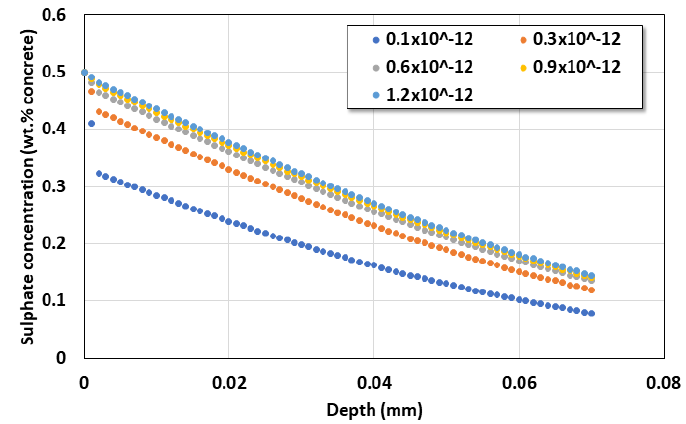
Figure 12. Sulfate ion profile after 40 years.